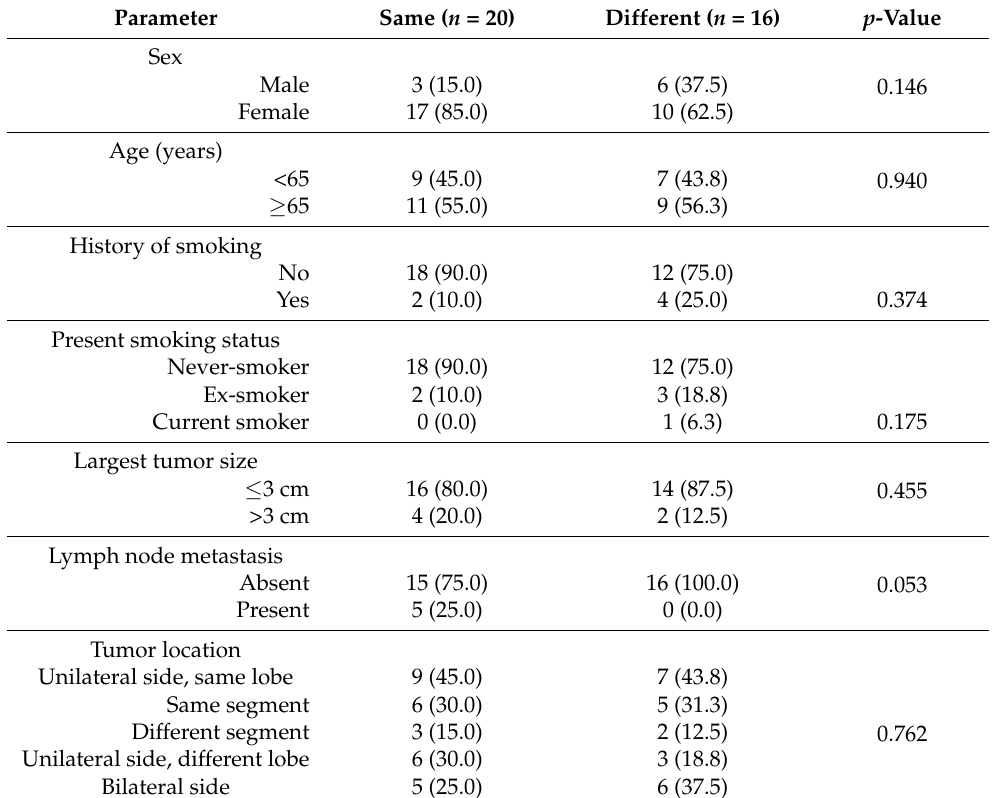
Table 3. Comparison of demographic parameters between patients with same EGFR mutation and those with different EGFR mutations in the EGFR -mutant/mutant